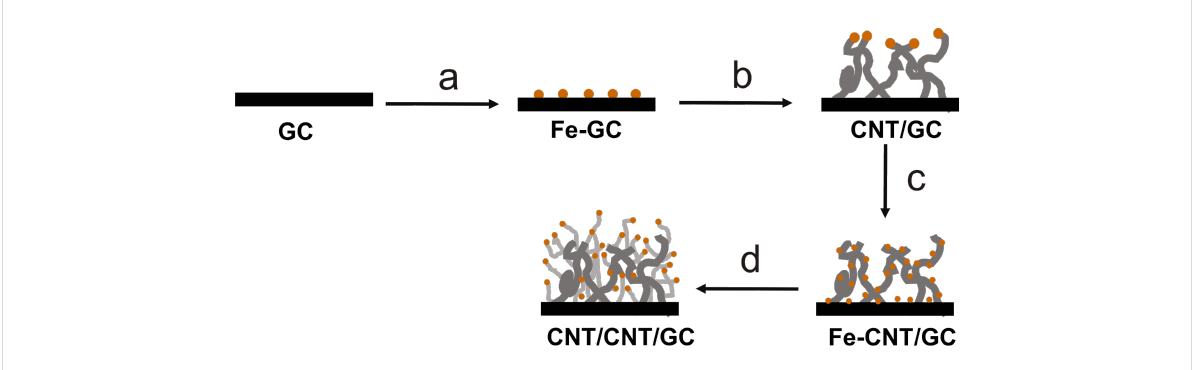
Figure 1: Scheme of the preparation of hierarchically nanostructured electrodes: a) electrochemical deposition of Fe nanoparticles onto oxidized GC; b) CNT growth onto GC through CVD; c) deposition of Fe nanoparticles onto CNTs and GC; and d) growth of secondary CNTs onto primary CNTs.